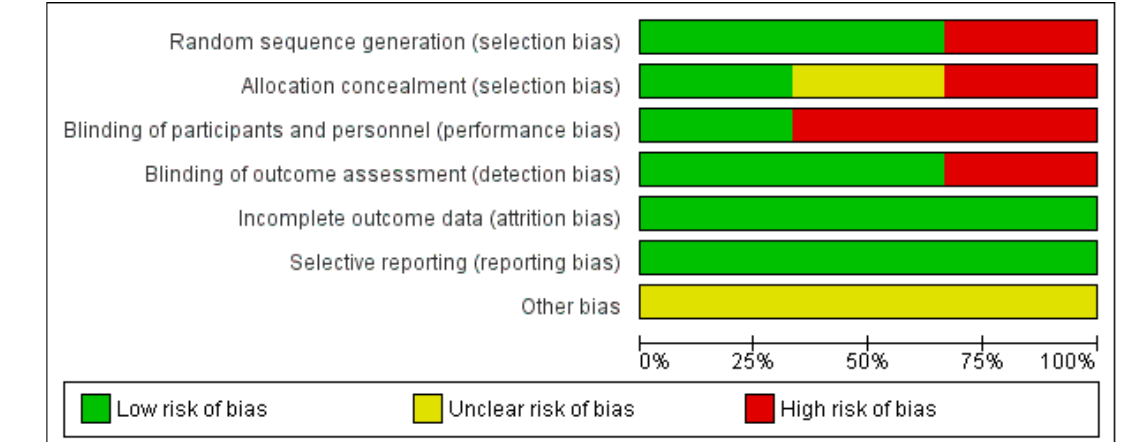
Figure 2. Risk of bias summary.